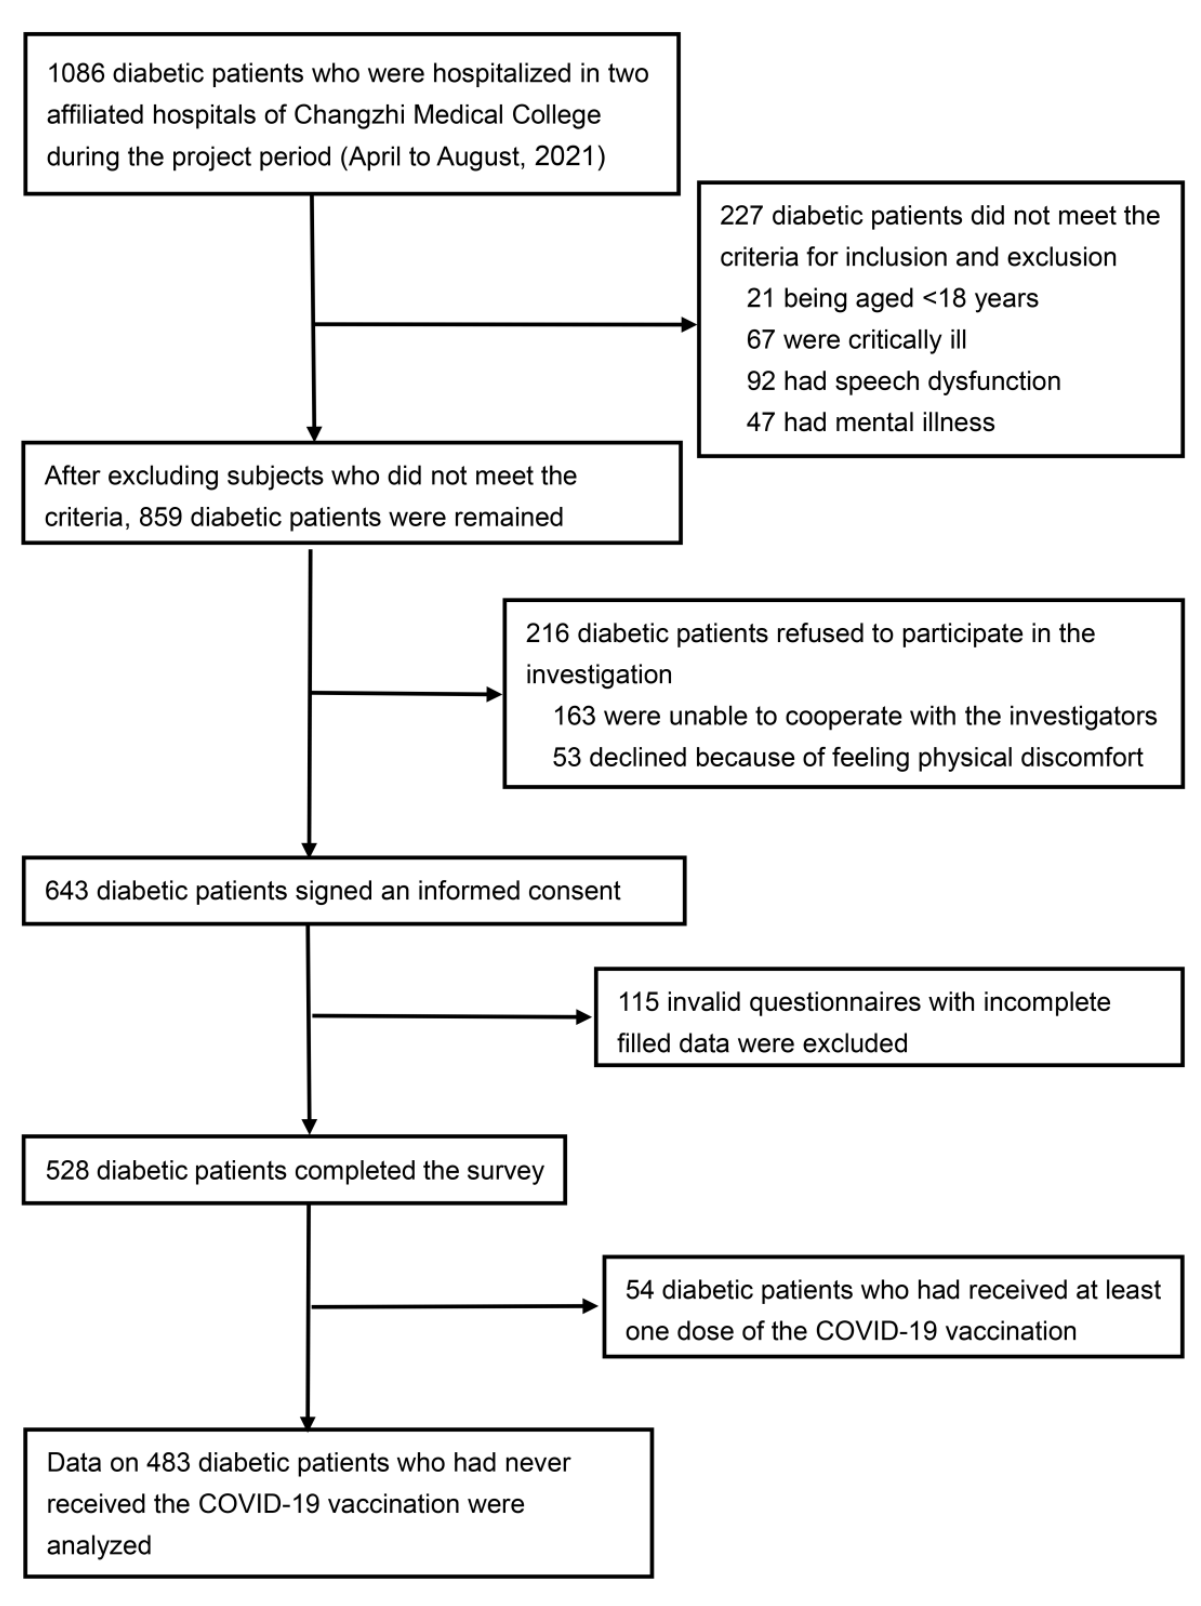
Figure 1. Flowchart of data collection.